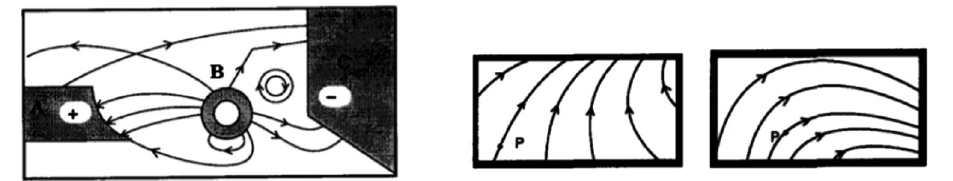
FIG. 1. Electric field lines presented to students in Tornkvist et al. ’ s study (1993). Left: The error finding task. Right: Two examples of the tasks administered during the